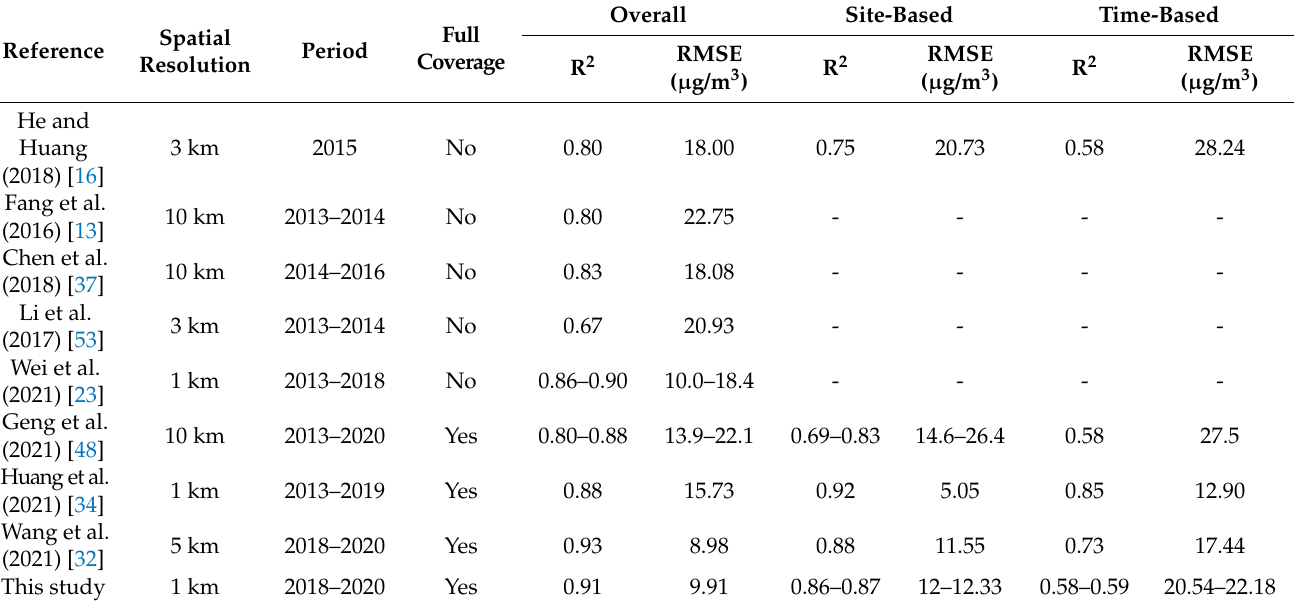
Table 2. Comparisons of model performance with previous studies at the national scale in